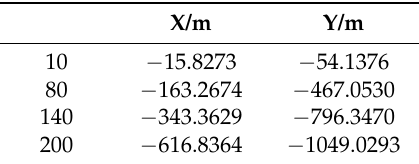
Table 6. Amplitude and difference of yz plane swing in different conditions.